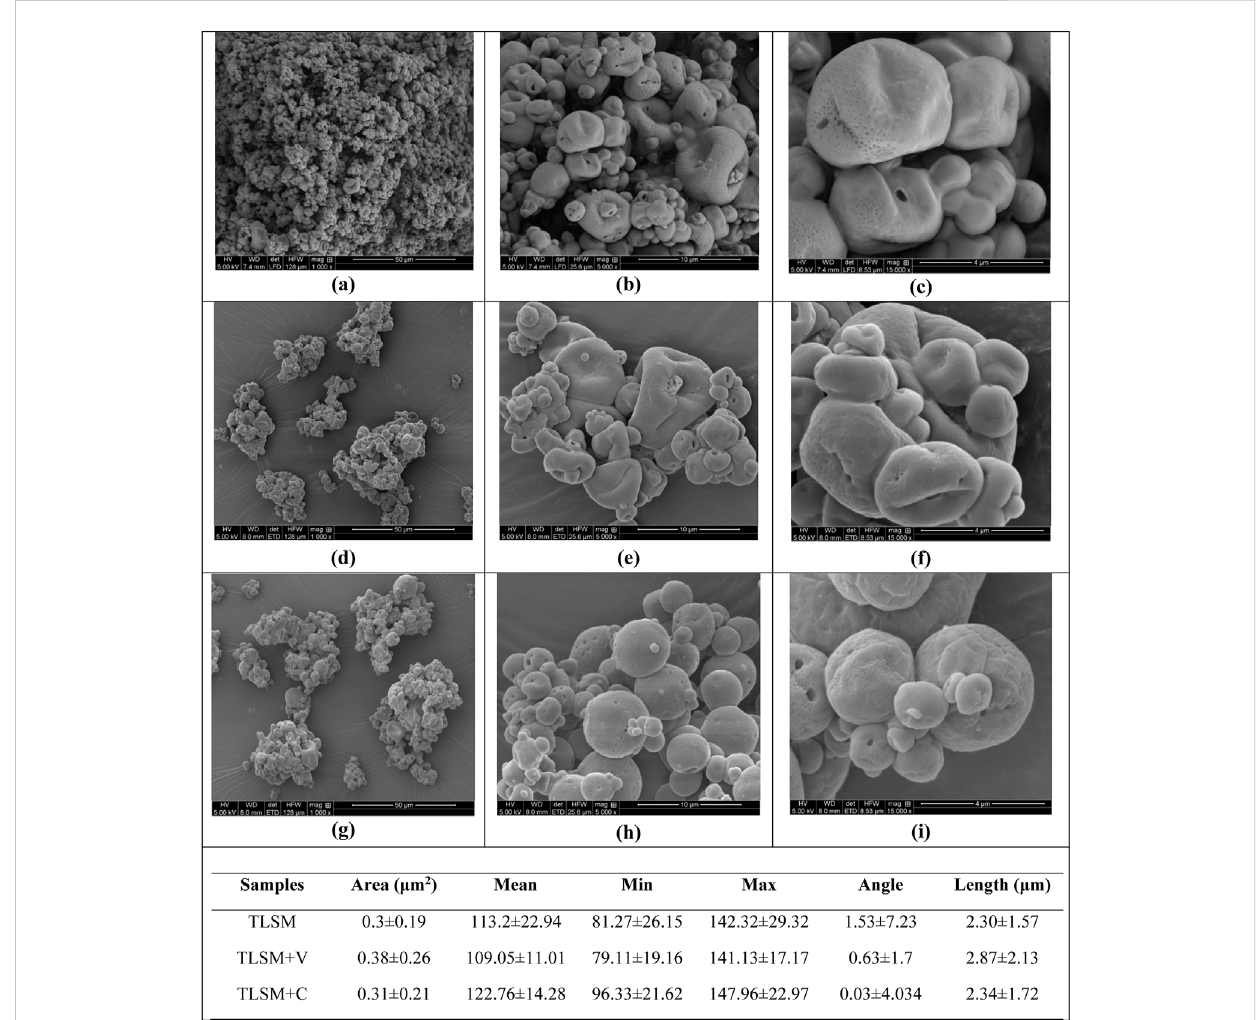
FIGURE 4 SEM images of spray dried TLSM powder at magni fi cation (A) ×1,000 (B) ×5,000 (C) ×15,000 and fl avoring components such as vanilla (D – F) and chocolate (G – I) at the same magni fi cation.